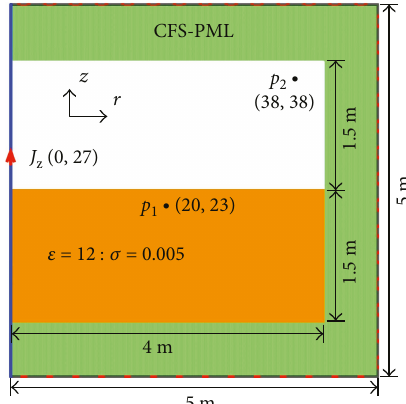
Figure 1: The con fi guration of the computational